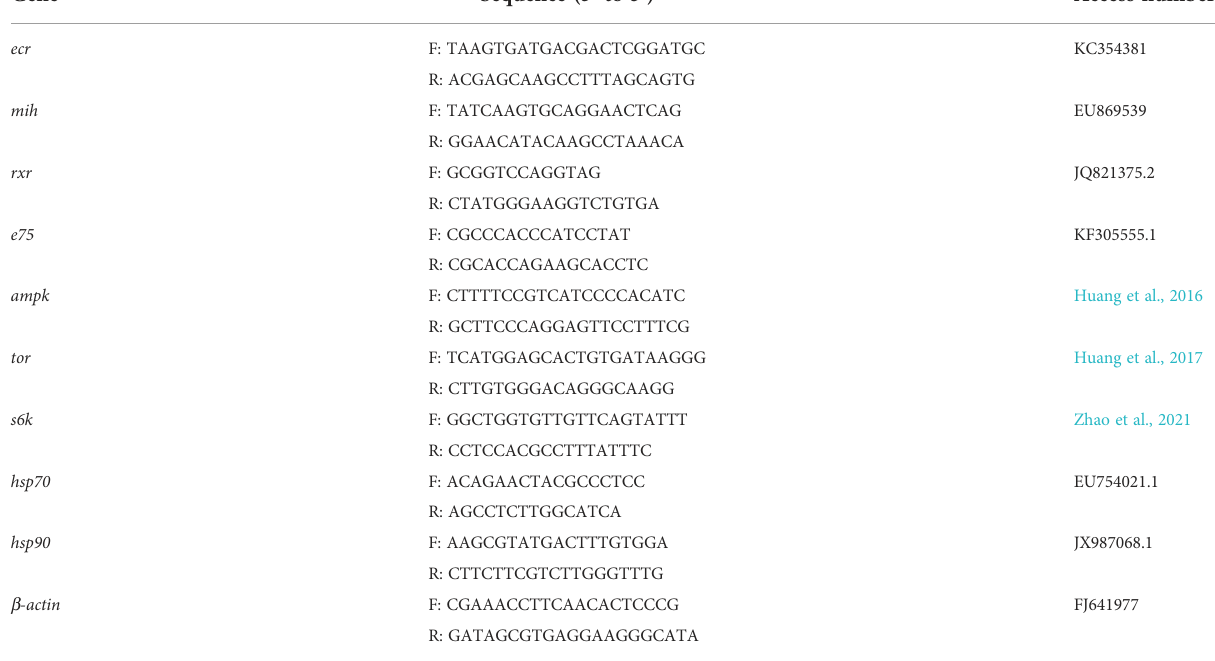
TABLE 1 Speci fi c primers were used for real-time PCR in this